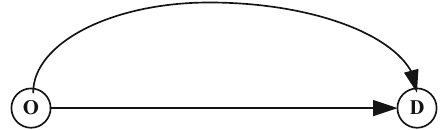
Fig. 1 A simple network consisting of two parallel paths/links